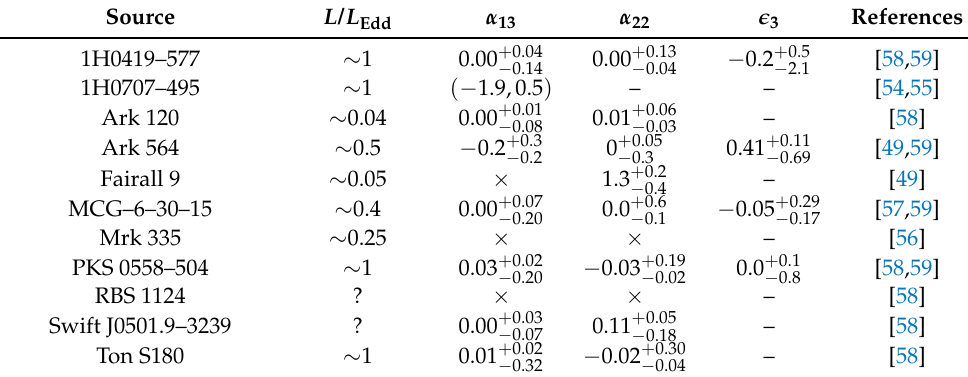
Table 2. Measurements of the deformation parameters α 13 , α 22 , and (cid:101) 3 from the 11 supermassive black holes that we have studied until now. We report the uncertainties at 90% confidence level (statistical error only) for one relevant parameter. The Kerr metric is recovered when the deformation parameters vanish. – indicates that we have not measured that deformation parameter for the corresponding object. × indicates that we tried to measure the deformation parameter but it was not possible to get any clear constraint. See the references in the last column for more